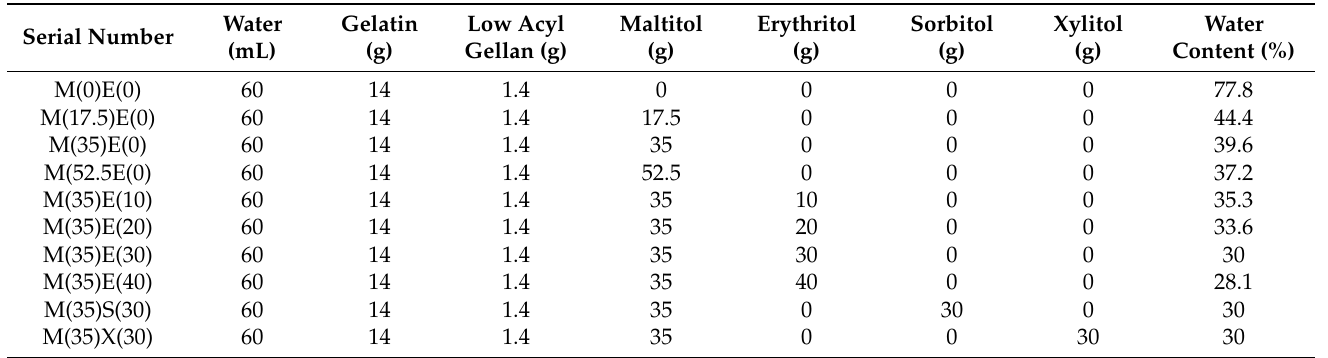
Table 1. Composition of the printable gummy ink formula and final water